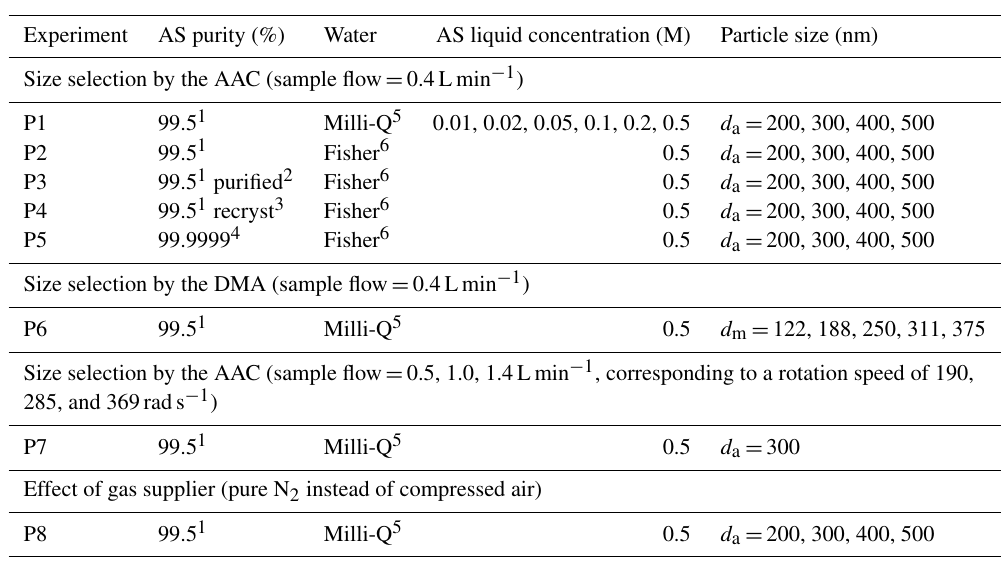
Table 1. Experiments to quantify organic traces on AS aerosol particles under various conditions: 1 AS 99.5%, for analysis, from Acros Organics™ Fisher Scientific; 2 purification by solvent (acetonitrile) extraction; 3 purification by recrystallization; 4 AS 99.9999% Suprapur ® from Merck. 5 Milli-Q water, 18.2M (cid:127) cm, TOC < 2ppb; and 6 Fisher Chemical, LC–MS grade. Under each condition, duplicate experiments were performed for each selected particle size. The four sizes ( d a = 200, 300, 400, and 500nm) selected with the AAC classifier correspond to the mobility sizes ( d m = 130, 201, 269, and